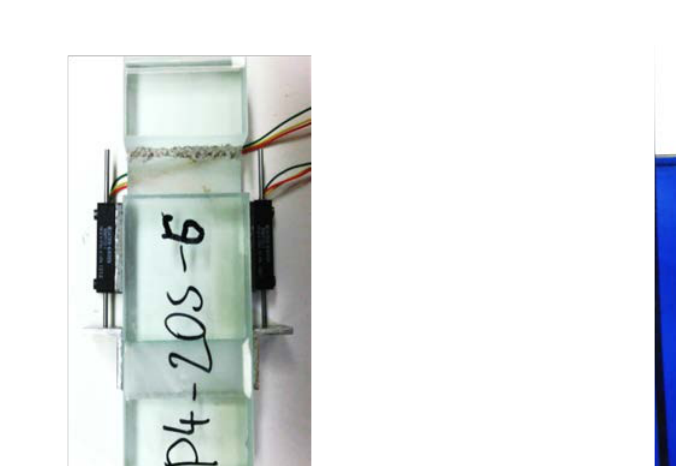
Fig. 1 Nominal dimensions of the testing